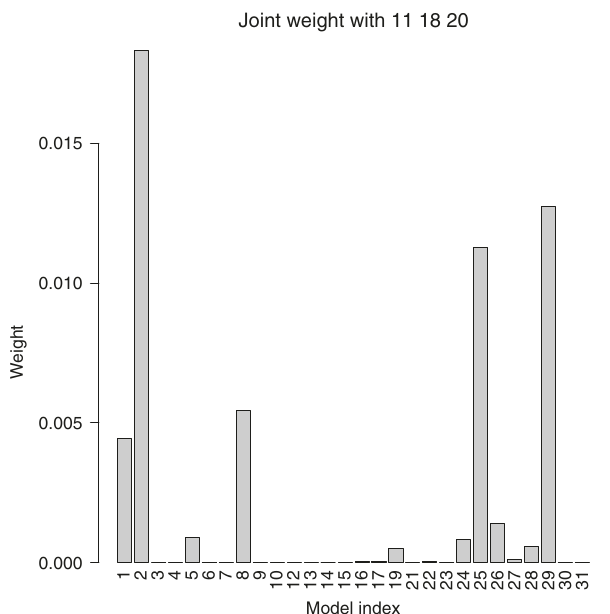
Fig. 3 Combination model probabilities. Joint weights of each climate model in combination with models 11, 18, and 20. This fi gure illustrates the power of the method to fi nd probability of any desired combination of hypotheses in a given